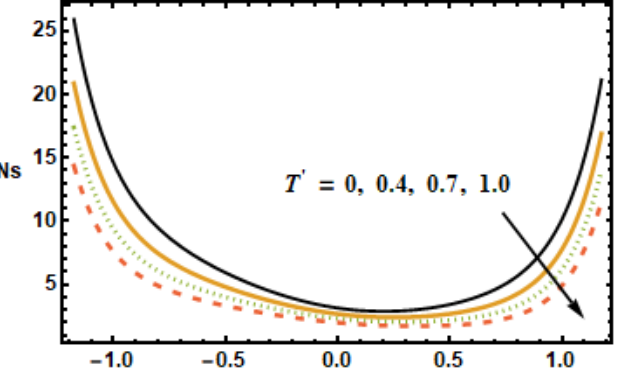
Figure 23. Effects of rotation parameter